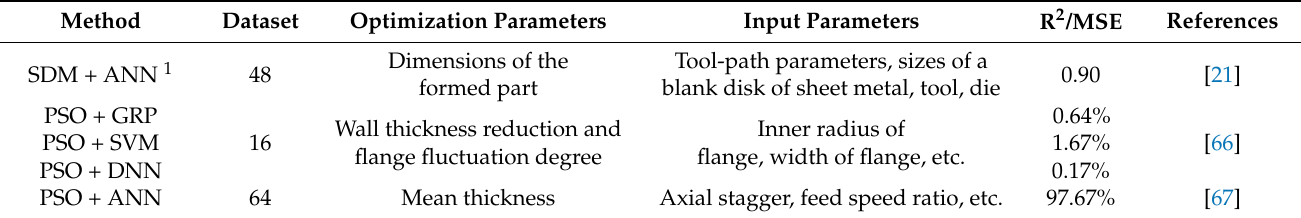
Figure 9. The architecture of the online intelligent design system for the roller path [66]. Table 5. A summary of intelligent optimization methods for